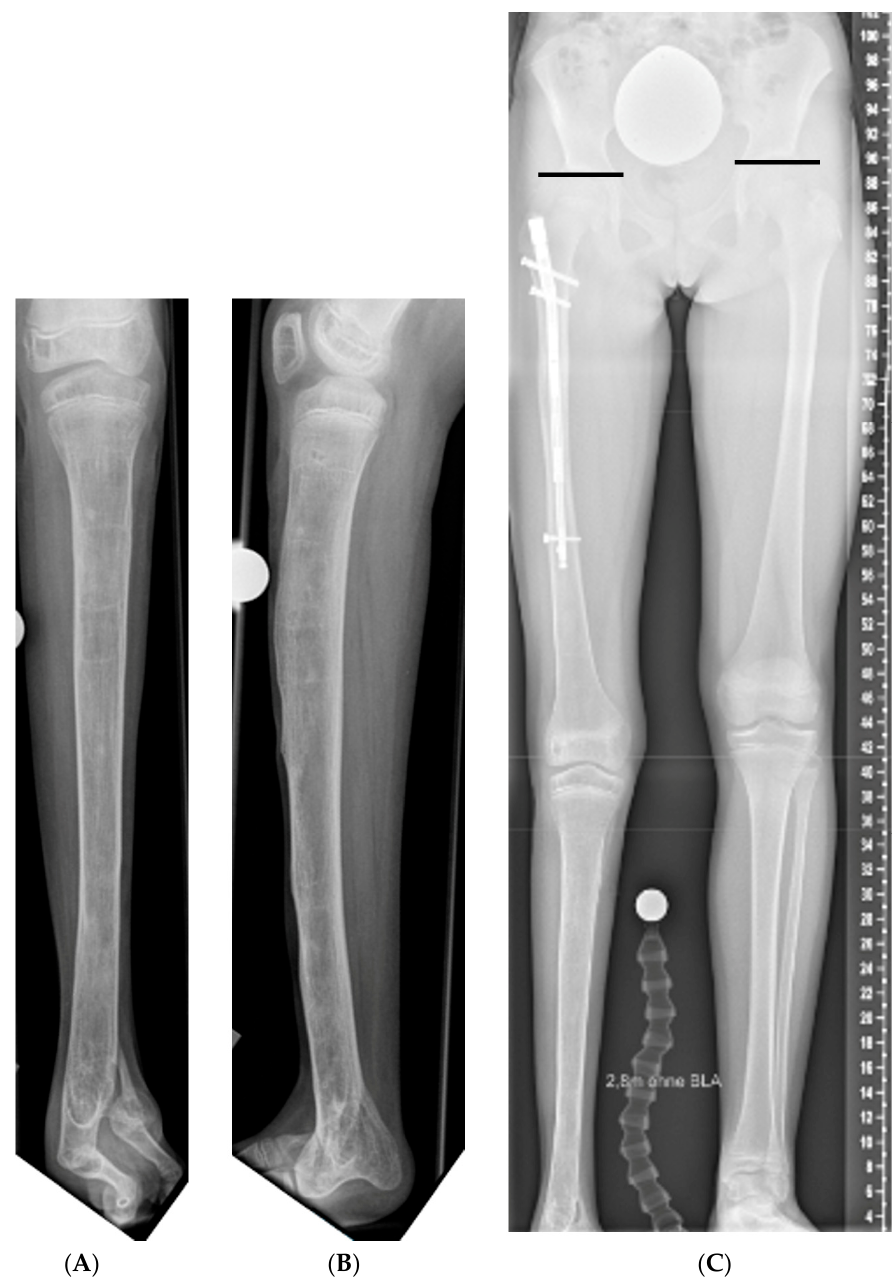
Figure 2. ( A , B ) Female patient with preexisting ankle fusion due to fibula hemimelia. ( C ) Residual leg length discrepancy of 1 cm was tolerated to facilitate walking.